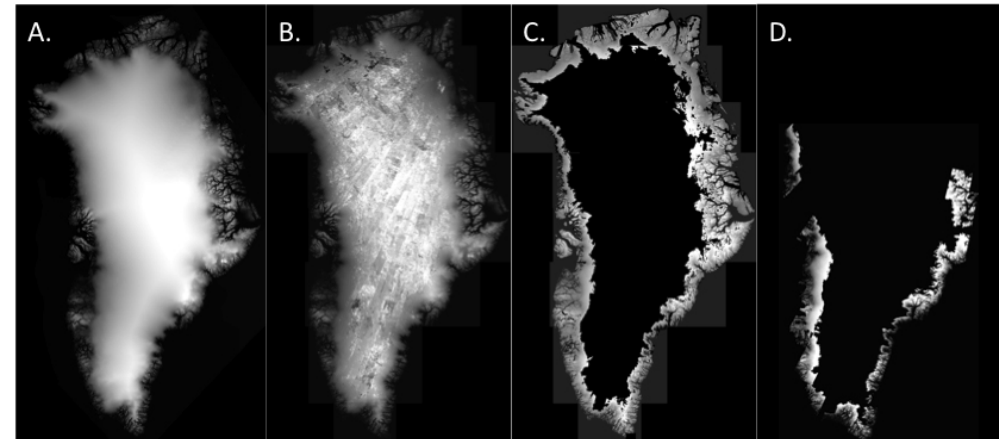
Figure 4. Grayscale representations of the input digital elevation models used to create the GIMP DEM, including the (a) photo-enhanced Bamber (PEB) DEM, (b) GDEM2, (c) filtered and masked GDEM2 and (d) SPIRT